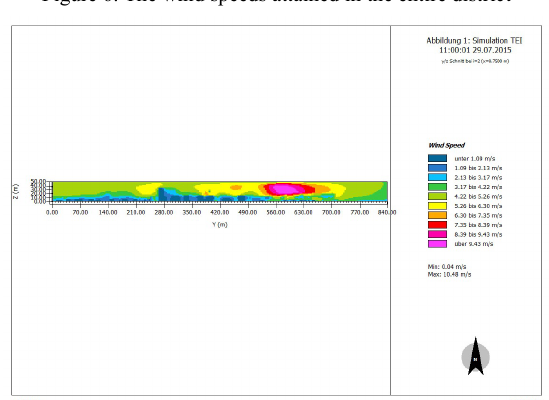
Figure 7. The wind profile in the y-z plane